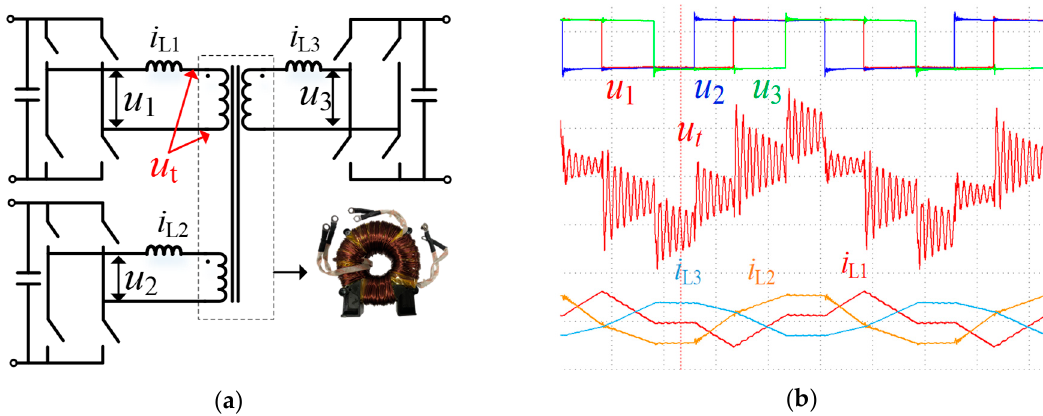
Figure 1. HFO in a MAB converter prototype: ( a ) TAB circuit; ( b ) waveforms.